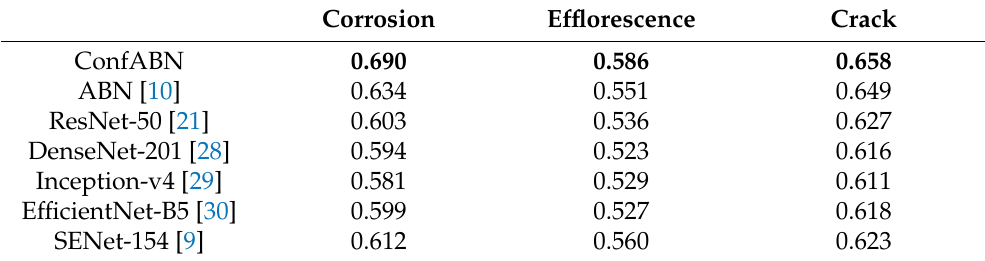
Table 7. Accuracy of ConfABN and comparative methods in estimating deterioration levels of the three types of